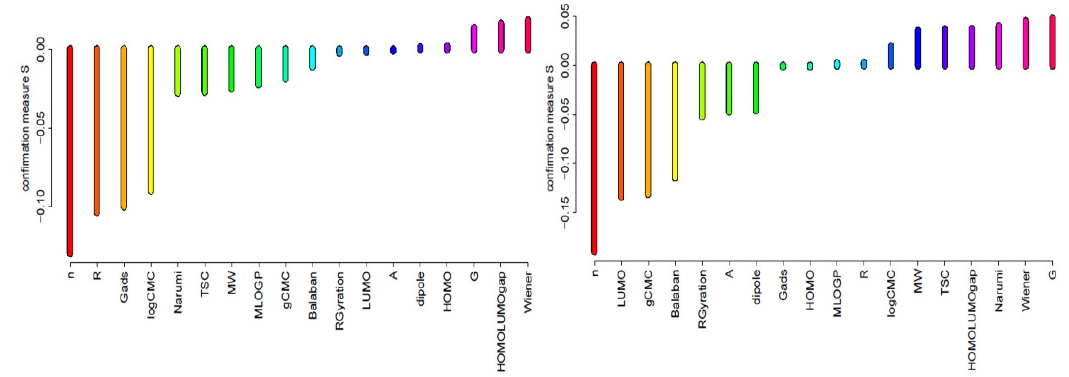
Int. J. Mol. Sci. 2021 , 22 , x FOR PEER REVIEW Figure 1. Predictive attribute confirmation calculated for MIC decision classes SAU “weak” (left) and “good” (right).